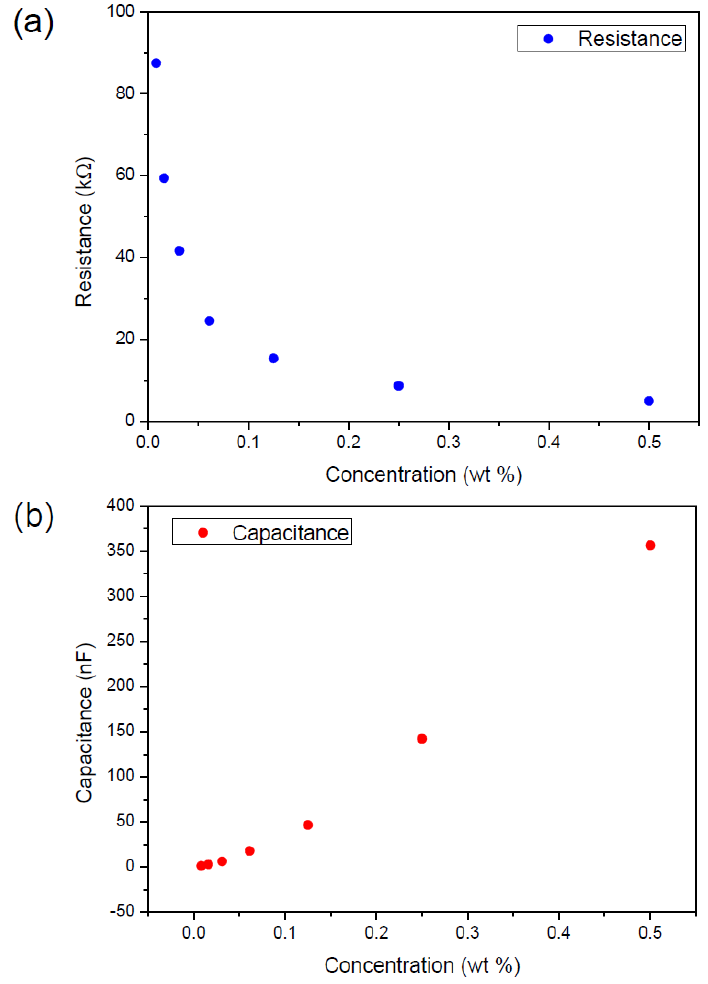
Figure 2. The effect of CuTsPc concentration on ( a ) resistance, and ( b ) capacitance of the ITO/CuTsPc solution/ITO cell.